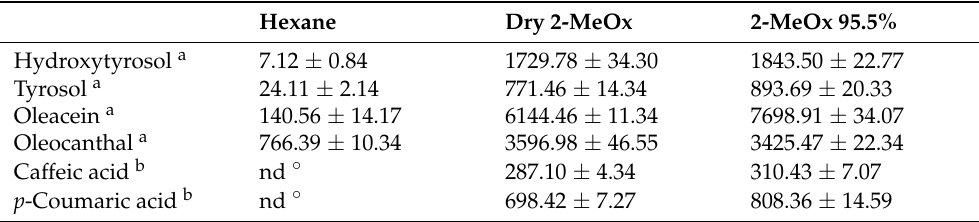
Table 5. Phenolic compounds (mg/Kg extract) quantification in OP extracts obtained with hexane, dry 2-MeOx and 2-MeOx 95.5%.